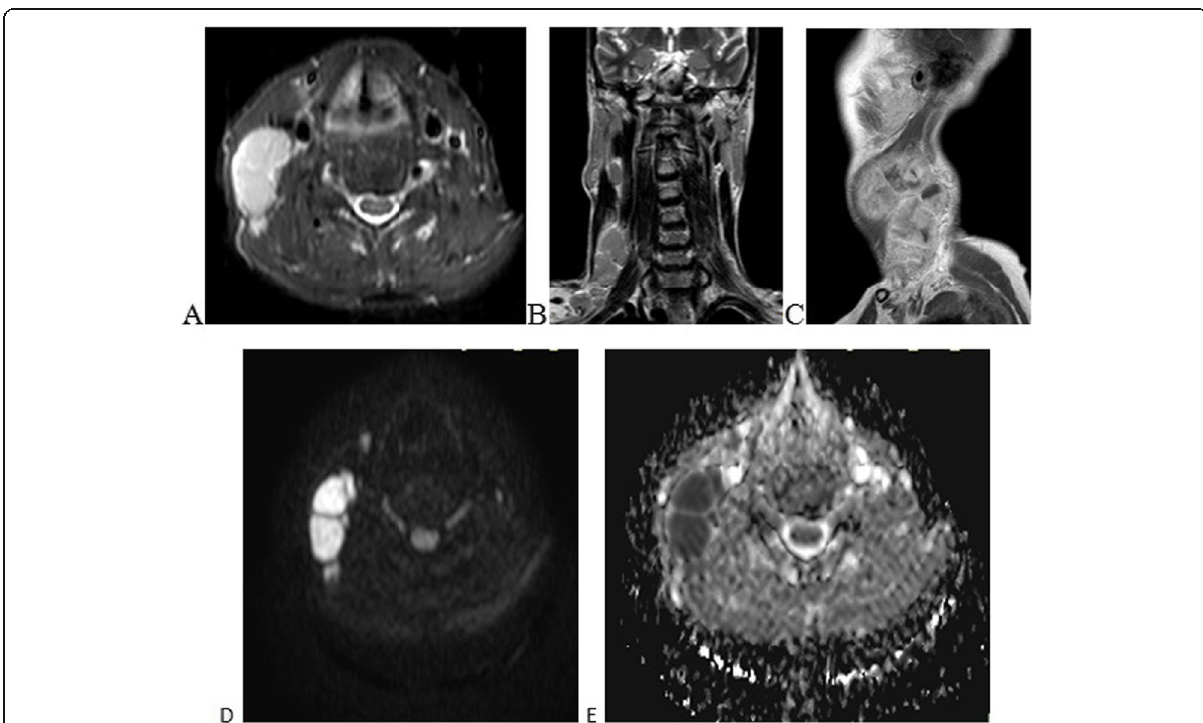
Fig. 7 Forty-five- year-old male, known case of non-Hodgkin lymphoma with enlarged right deep cervical lymph nodes. a Axial STIR WIs and b coronal T2 WI s showing high signal of the enlarged nodes. c Post-contrast sagittal T1 WIs showing heterogeneous contrast uptake . d DWIs b 1000 and e ADC map showing hyperintense LNs in diffusion WIs corresponding to low signal in ADC map , with an ADC value of 0.723 × 10 − 3 mm 2 /s; the possibility of lymphomatous nodal infiltrate was considered and proven by